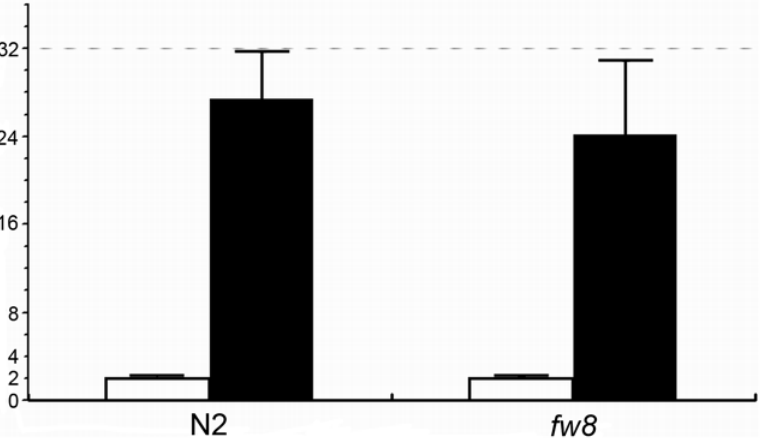
Figure 6. Intestinal Ploidy Measurement of bub-1 Mutants. Body wall muscle nuclei were used as an internal 2 n standard. White bar indicates the average DNA content 6 s.d. of 10 body wall muscle nuclei in three independent animals. Black bar indicates the average DNA content 6 s.d of 30 intestinal nuclei in three independent animals.